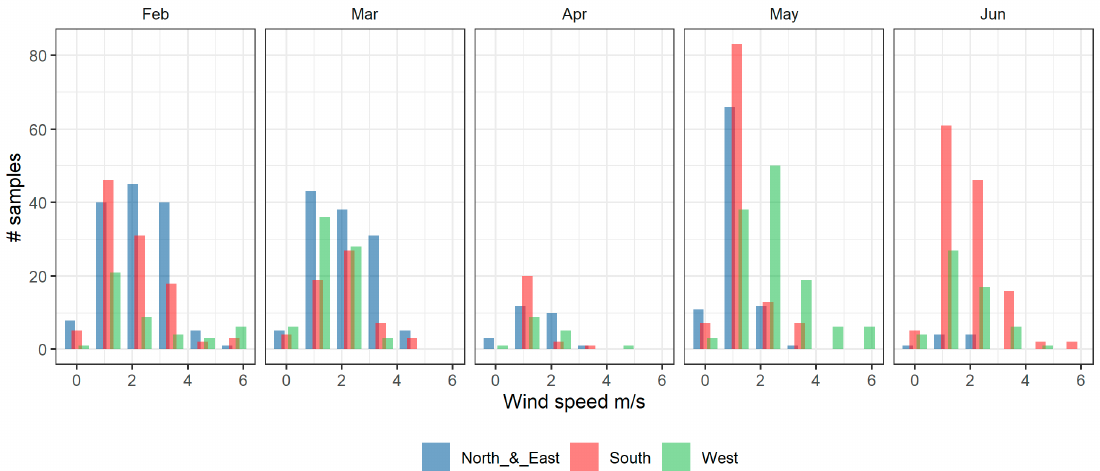
Figure 7. Wind speed frequency distribution per month during the COALA-JOEYS. Only the wind speed data of the sampling period were included.